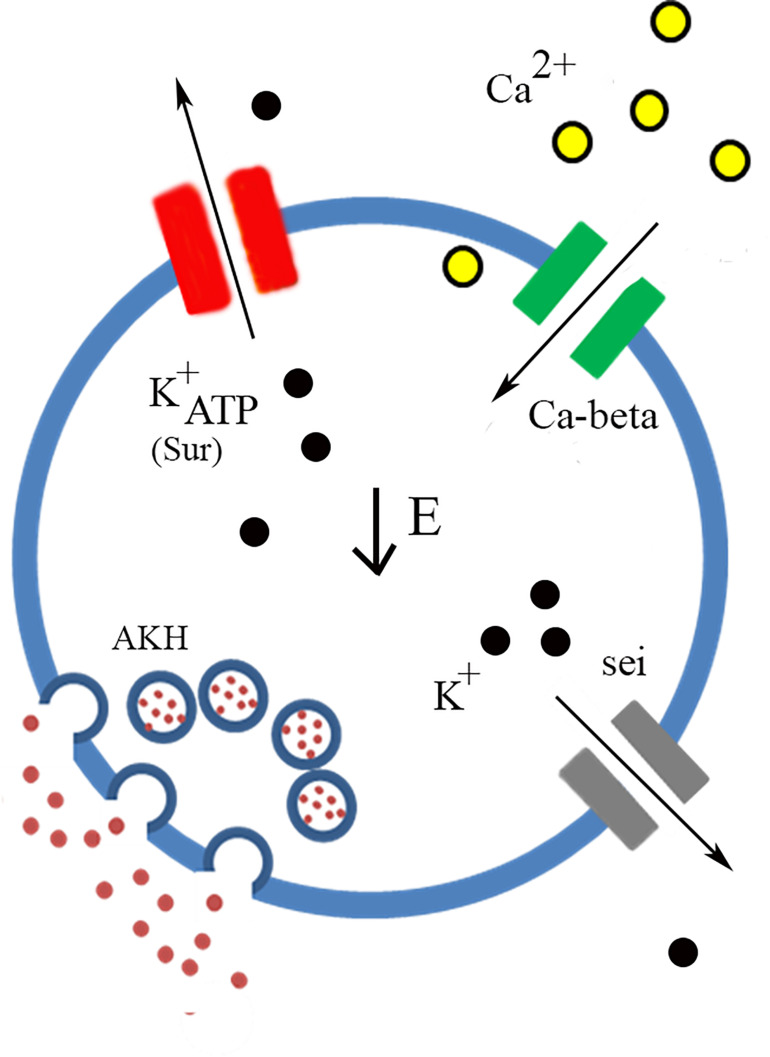
Model of AKH cell excitability. Low Energy (center) is the trigger that facilitates AKH release. Nutrient sensing is likely to occur through the ATP gating of K+ATP channels of which Sur is an essential component. Calcium enters through the cell through calcium channels and the Ca-beta subunit is likely a critical component of functional calcium channels present in AKH cells. Potassium channels, likely containing sei subunits, also participate in the regulation of AKH cell excitability and the subsequent secretion of the hormone.